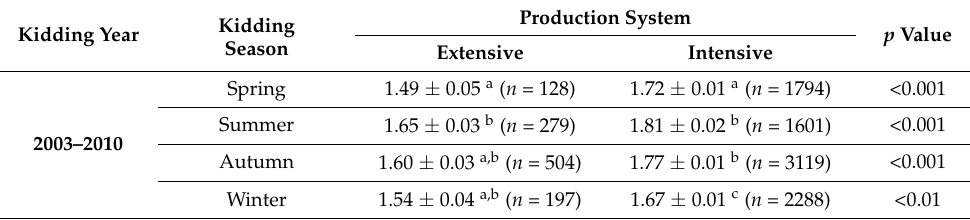
Table 4. Effects of production system, kidding season and kidding year on prolificacy (mean ± SE) of multiparous Florida goats.